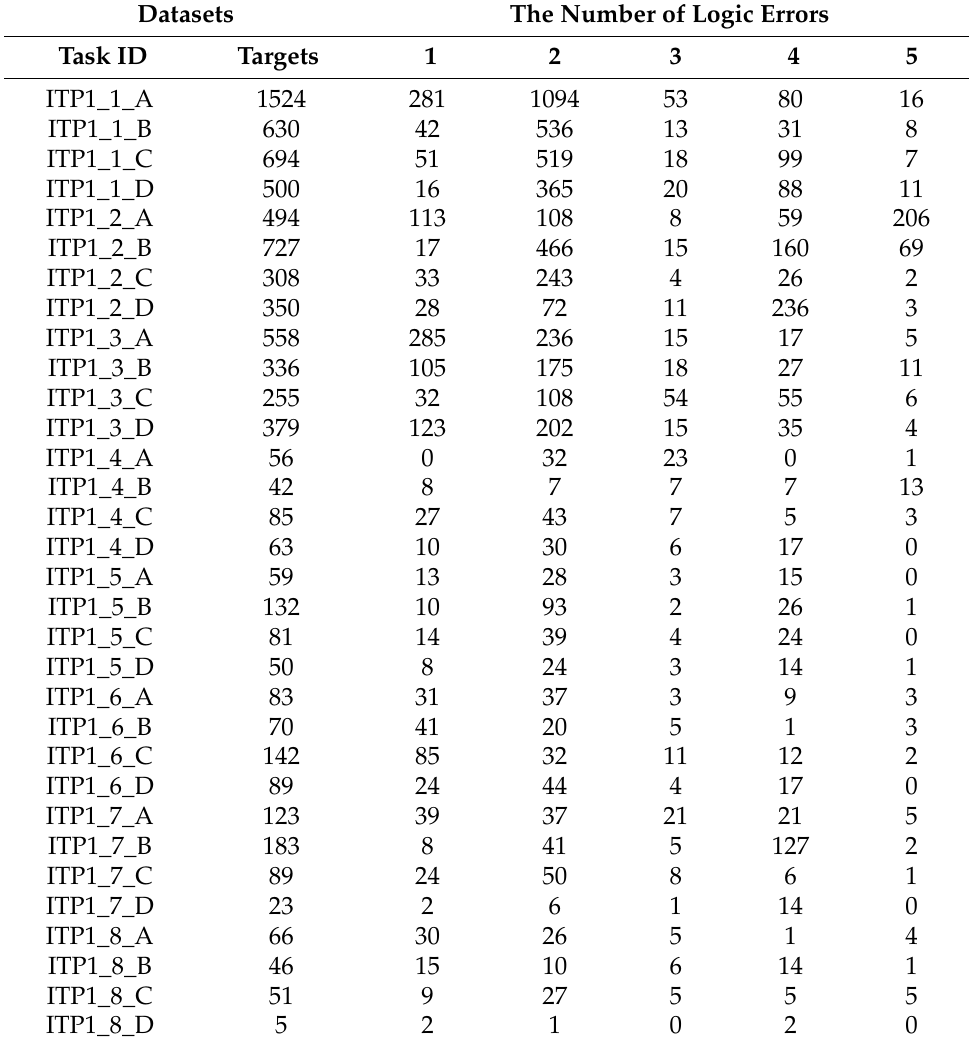
Table 5. Details of experimental